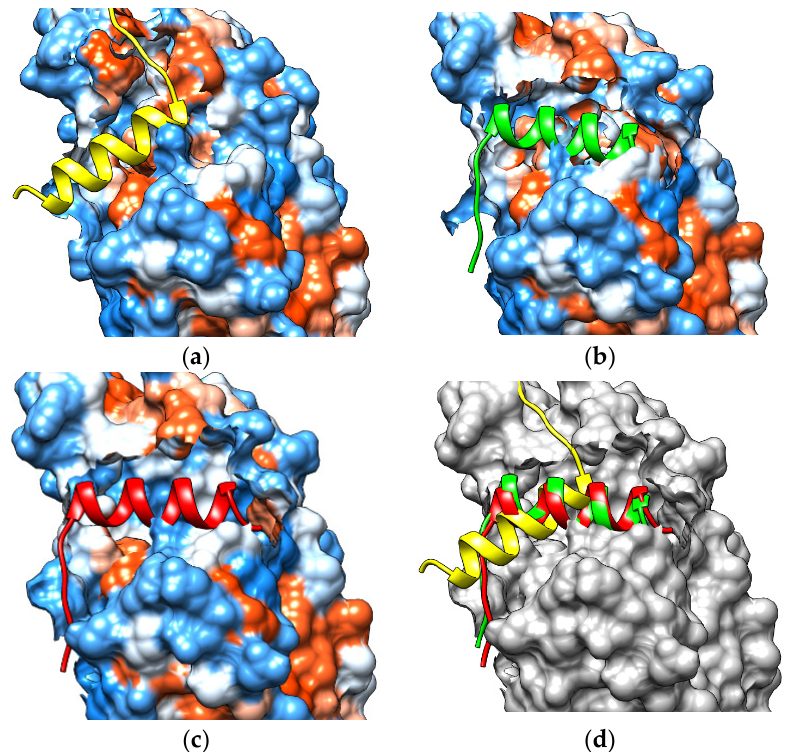
Figure 12. Visualization of the peptide-docking results between the nuclear receptor corepressor (NCoR) and ( a ) the crystal structure, ( b ) the CoPP-complex, ( c ) the Heme-complex, and ( d ) overlay NCoR in crystal structure (yellow), CoPP-complex (green), and Heme-complex (red).